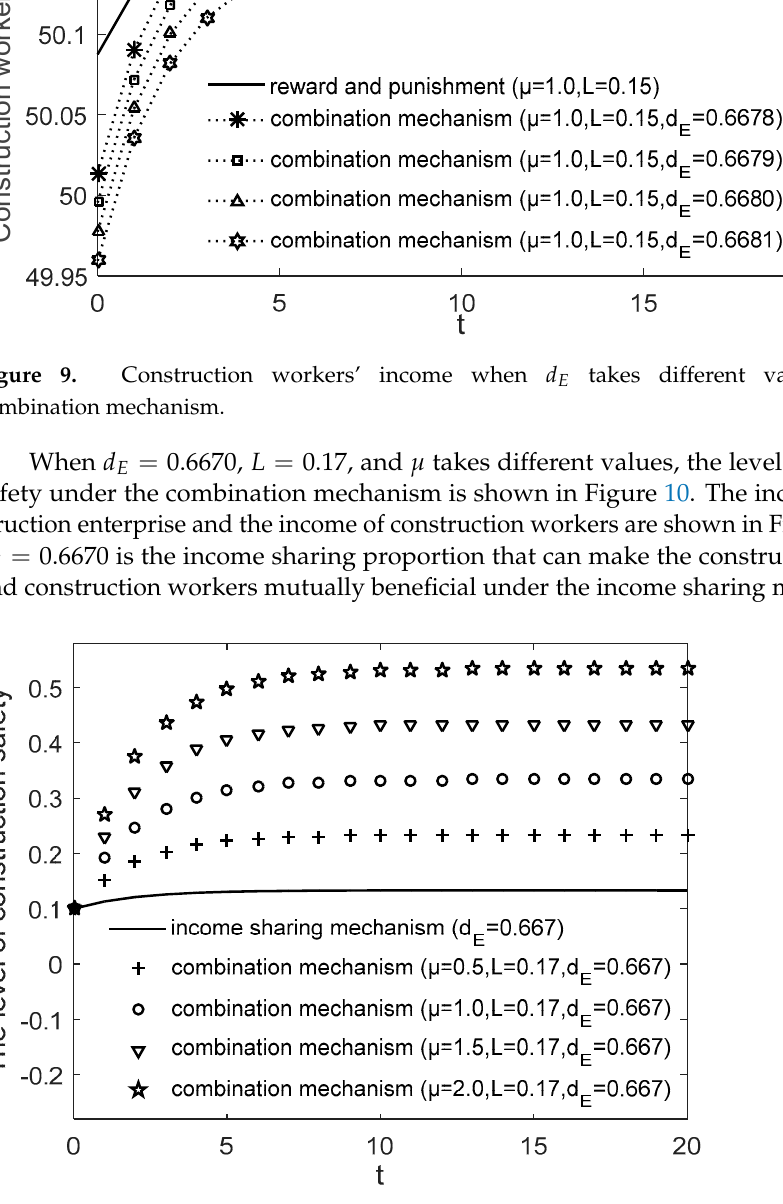
Figure 10. The level of construction safety when µ takes different values under the combination mechanism.